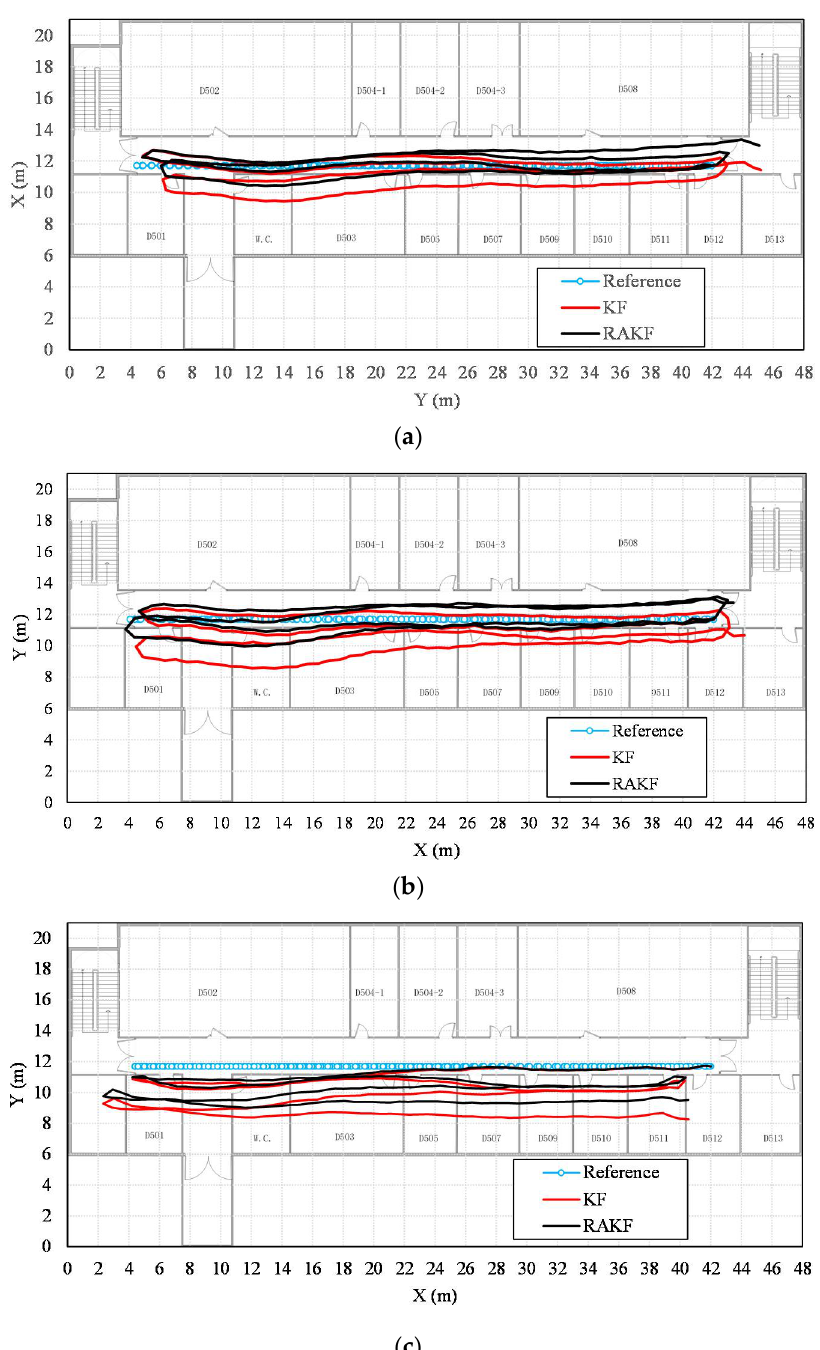
Figure 8. Comparisons of the performances on location tracking of KF and RAKF with respect to three participants, ( a ) participant 1, ( b ) participant 2, and ( c ) participant 3.